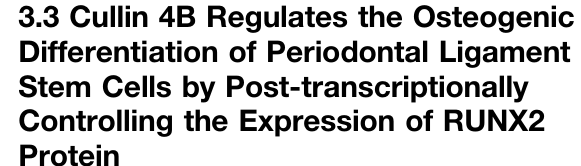
Frontiers in Cell and Developmental Biology |